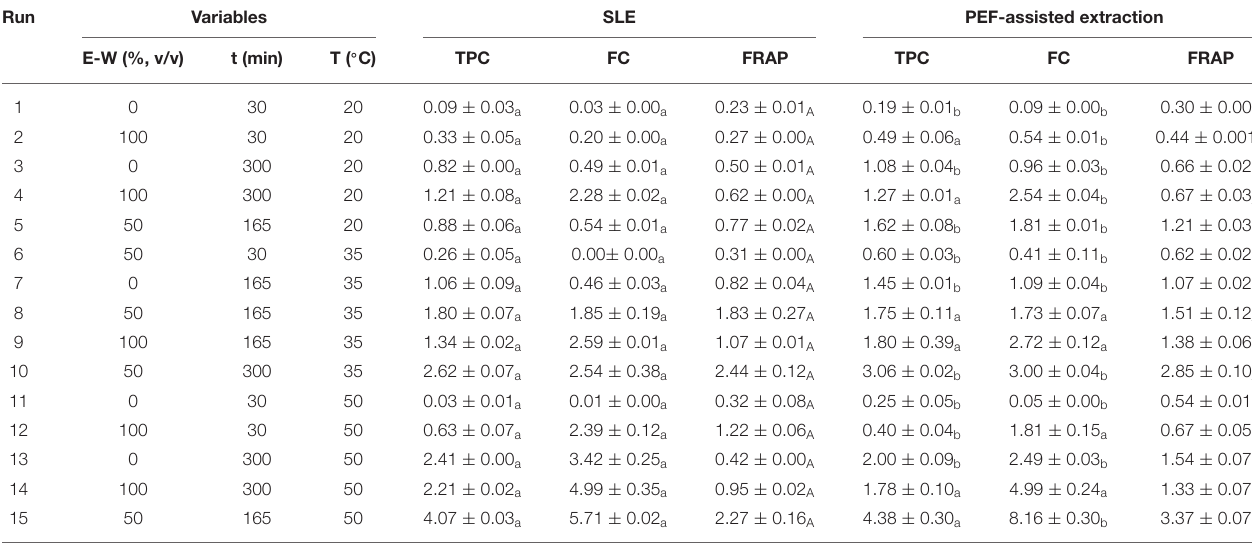
TABLE 3 | Actual values of the three independent variables investigated and responses of the dependent variable (TPC, FC, and FRAP) in grape pomace extracts from either conventional SLE or PEF (3.9 kV/cm, 10kJ/kg)-assisted extraction process. Run Variables SLE PEF-assisted extraction E-W (%,